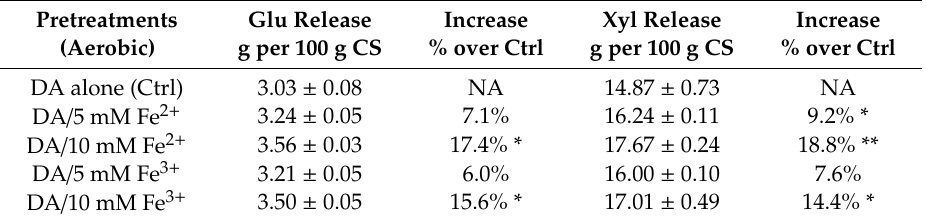
Table 2. Release of glucose and xylose from corn stover by DA / Fe pretreatments (at 150 ◦ C, 20 min) under aerobic conditions. The released sugars were quantitated by HPLC analysis of the liquor after the pretreatment. Values are presented as means ± standard error of the mean ( ± SEM) of four replicates for each of the pretreatments. Asterisk indicates statistically significant di ff erence from the control (* for p < 0.05; ** for p < 0.01). Abbreviations: CS, corn stover; Ctrl, control; DA, dilute acid; Glu, glucose; NA, not applicable; Xyl,